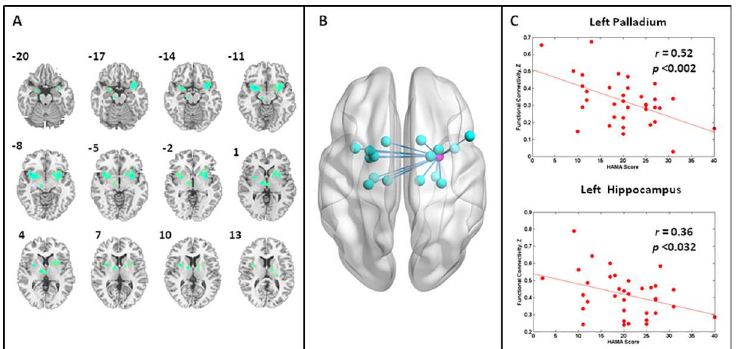
Fig 2. Regions showing significantly altered connectivity with the amygdala in females with MDD compared to HC. Panel A shows significantly altered connectivity with the amygdalain females with MDD comparedto HC. Panel B shows the statistical maps renderedon a SurfTemplate by using the BrainNet Viewer(http://www.nitrc.org/projects/bnv); the magentadot is the seed–theright amygdala;aquamarine dots indicatethe right VLPFC, bilateralinsula, bilateralparahippocampus, bilateral putamen, bilateralpallidus, and bilateralthalamusthat displayedsignificantly decreasedconnectivity with the amygdalain females with MDD relativeto HC. In contrast, no significantincreasedfunctionalconnectivity relevant to seed was detected amongfemales with MDD comparedto HC. The significancelevel was set as singlevoxel threshold of p < 0.01 and cluster size > 251 voxels, using AlphaSimcorrection. Panel C shows significantcorrelationsbetween connectivity and anxiety scores; the upper row displaysthe connectivityof the left pallidus, relevant to the right amygdala,significantly correlates with anxiety scores (r = 0.52, p = 0.0017); the bottom row displaysthe connectivity of the left hippocampus, relevantto the right amygdala,significantly correlates with anxiety scores (r = 0.36, p = 0.0314).